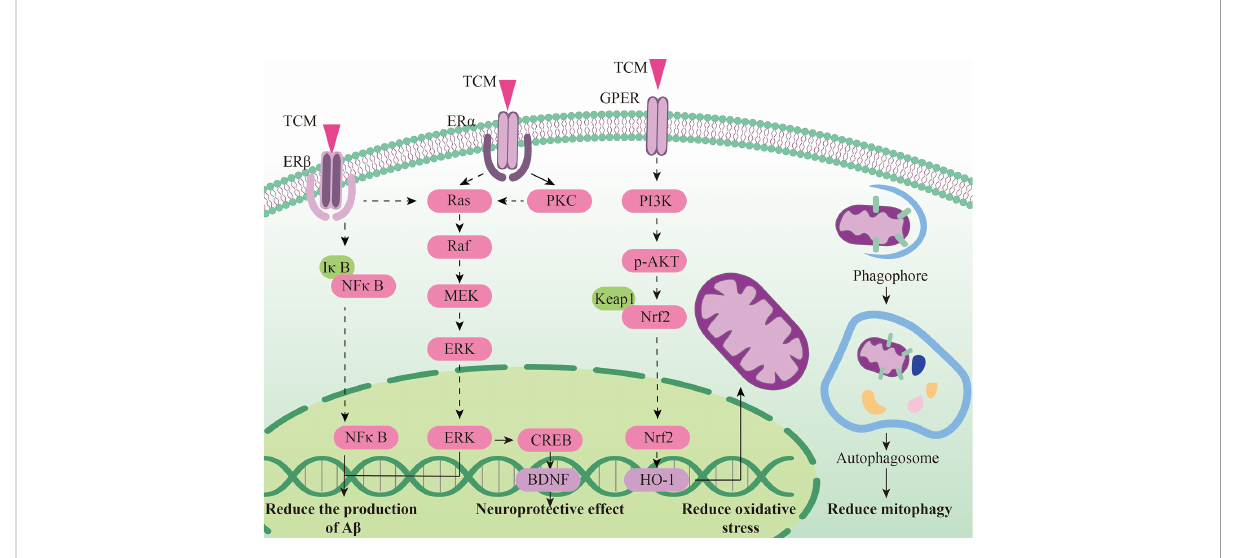
FIGURE 3 The neuroendocrine mechanism of TCM regulating HPG